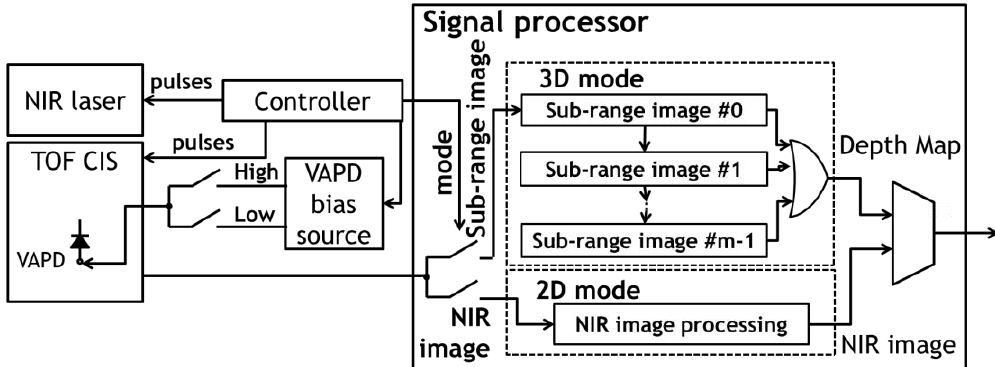
Figure 7. A schematic diagram of the system architecture of the TOF-CIS system.